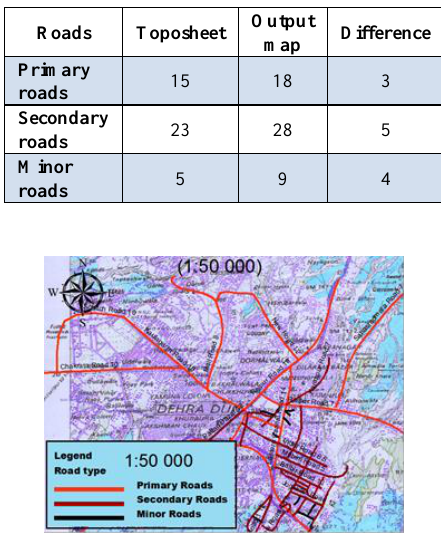
Figure 11: Overlay of the generalized road network map and topographic map of Uttarakhand 1:50 000, 53